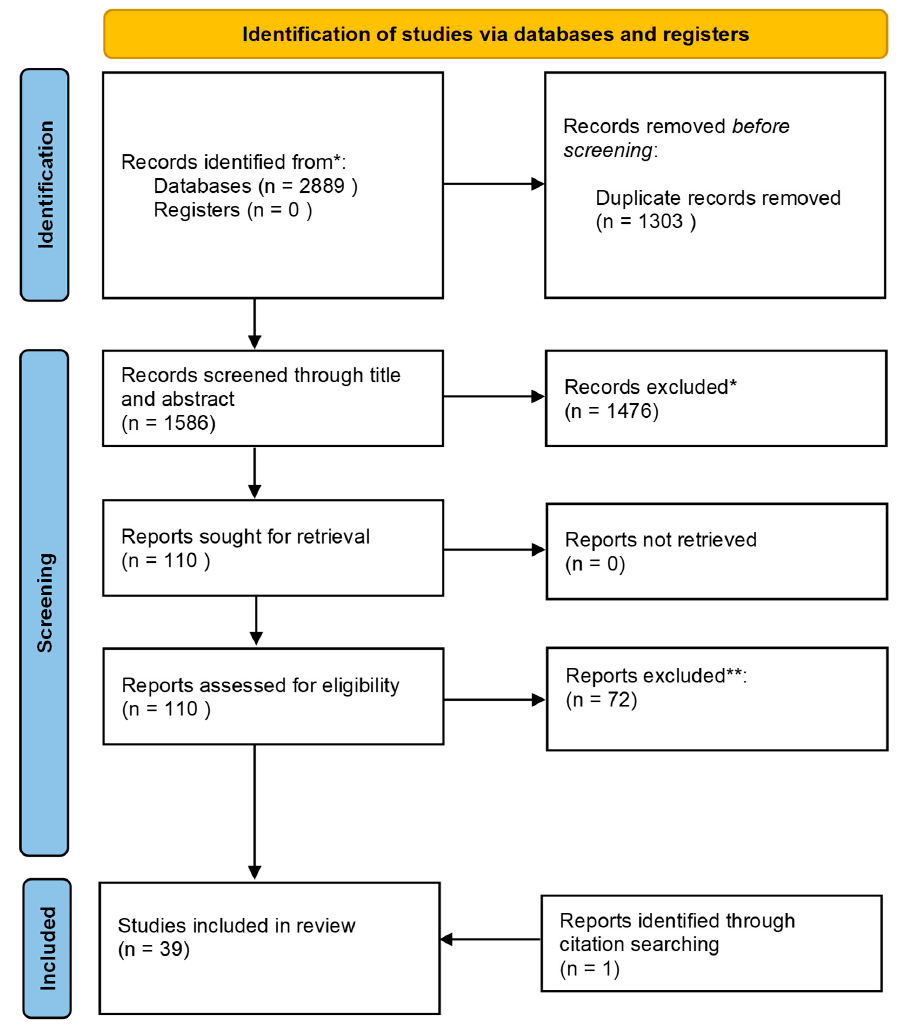
Figure 1. Flow of systematic review process according to PRISMA diagram after first search. * Records excluded via exclusion criteria in Table A2. ** Records excluded via exclusion criteria in Table